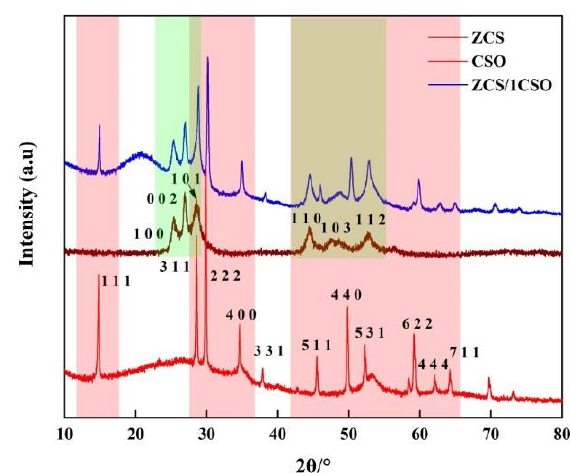
Figure 1. XRD patterns of ZCS, CSO, and ZCS/1CSO compound.